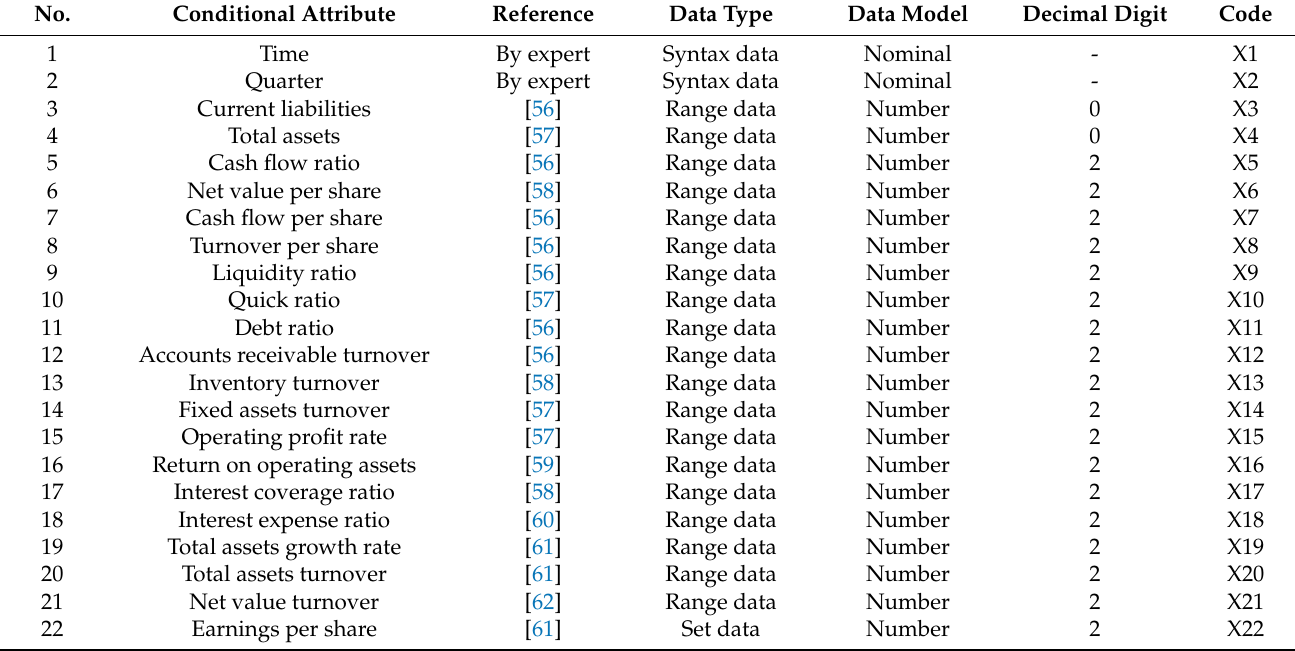
Table 1. Conditional attribute data type and